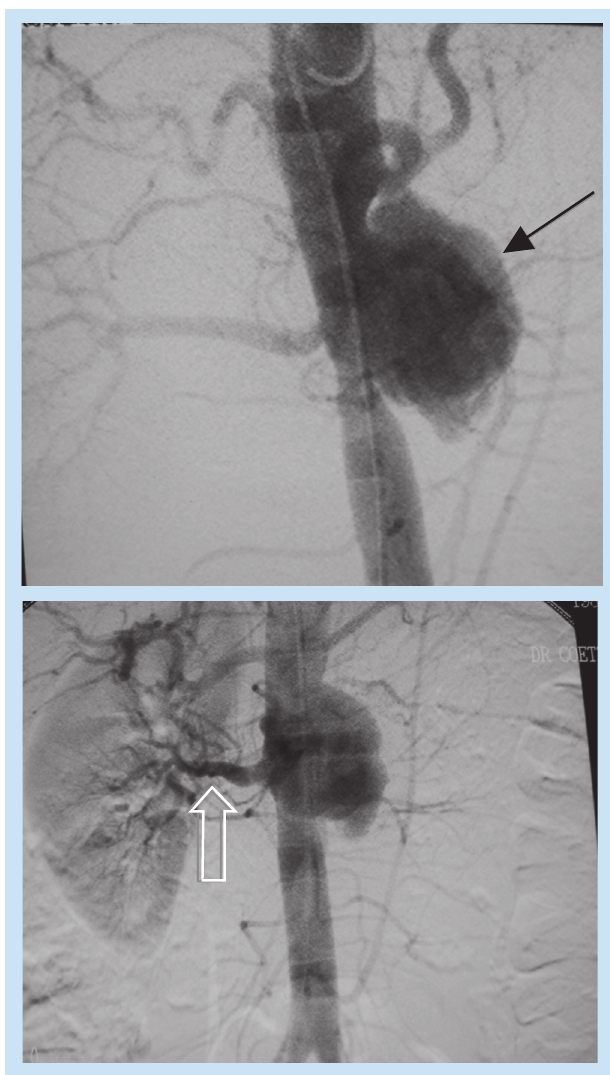
Fig. 12. Angiogram showing the left renal false aneurysm (arrow) with no visible left kidney. The right nephrogram is normal, although the right renal artery (open arrow) is irregular